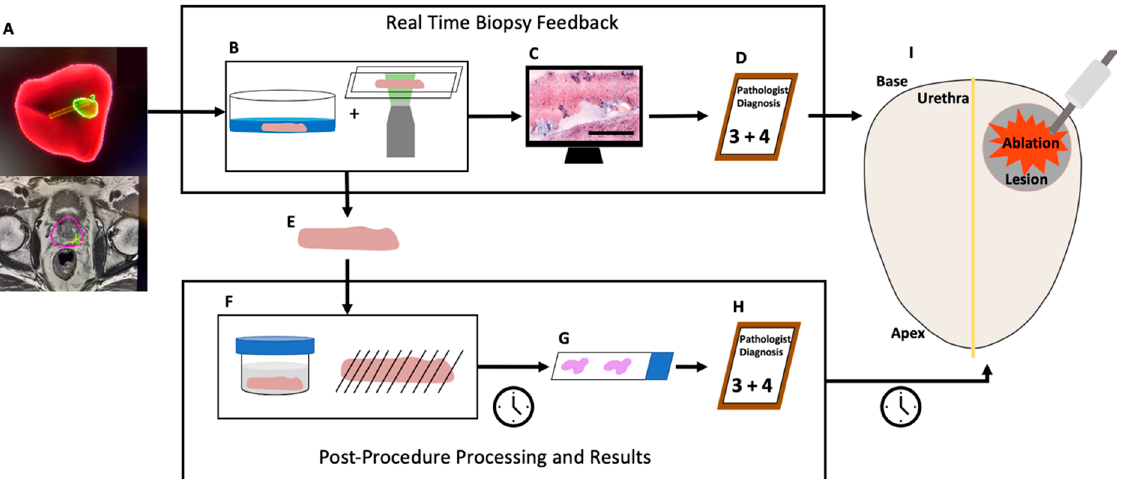
Figure 1. Potential “see-and-treat” localized prostate ablation informed by real-time SIM imaging compared to standard workflow. In this work, we assessed, retrospectively, the potential for SIM to provide real-time confirmation of lesion status during MRI-US-guided biopsy. A patient with a potentially malignant lesion with undefined boundaries enters the clinic and undergoes an MRI fusion transrectal diagnostic biopsy ( A ). SIM staining and imaging are performed immediately after excision ( B ). A digital H&E analog is generated ( C , scale bar represents 1 mm). This image is presented to a pathologist for diagnosis ( D ). The same biopsy is transported to histology ( E )